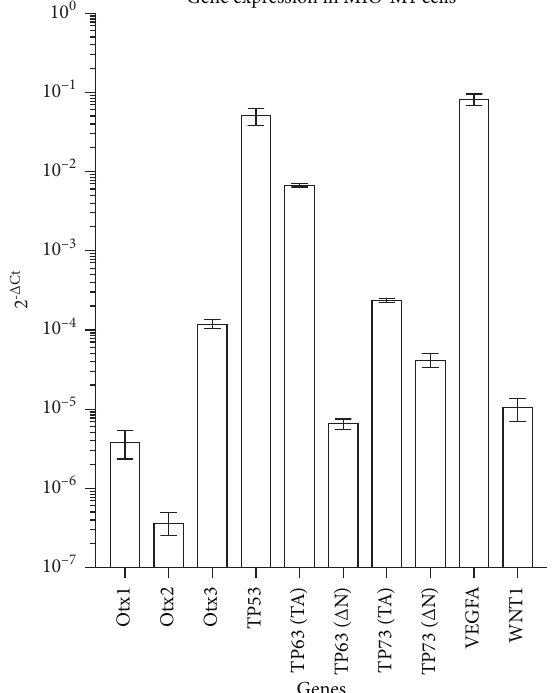
Figure 4: Molecular characterization of gene expression in untreated MIO-M1 cells. Each gene was normalized to β -actin expression level, to obtain a value representing the fold change between the two analyzed genes. On the Y -axis, the fold change value is reported. Each value is indicated as median ±